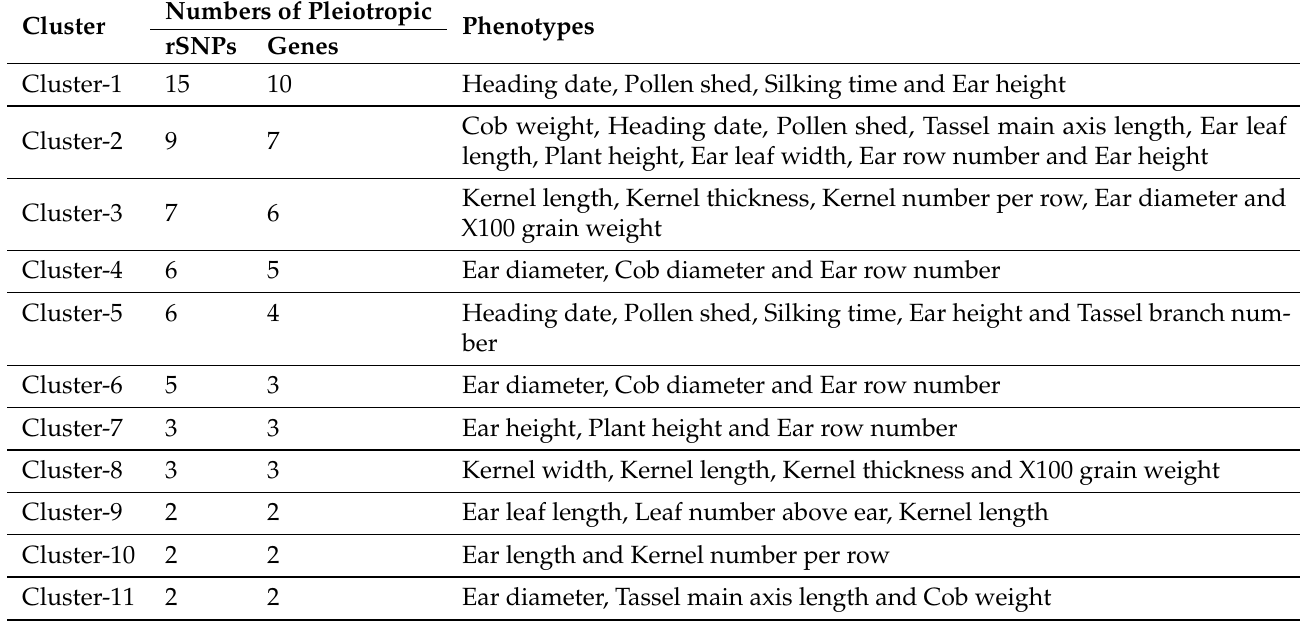
Table 2. Result of Markov clustering algorithm (MCL) including the numbers of rSNPs together with their related genes and their associated multiple